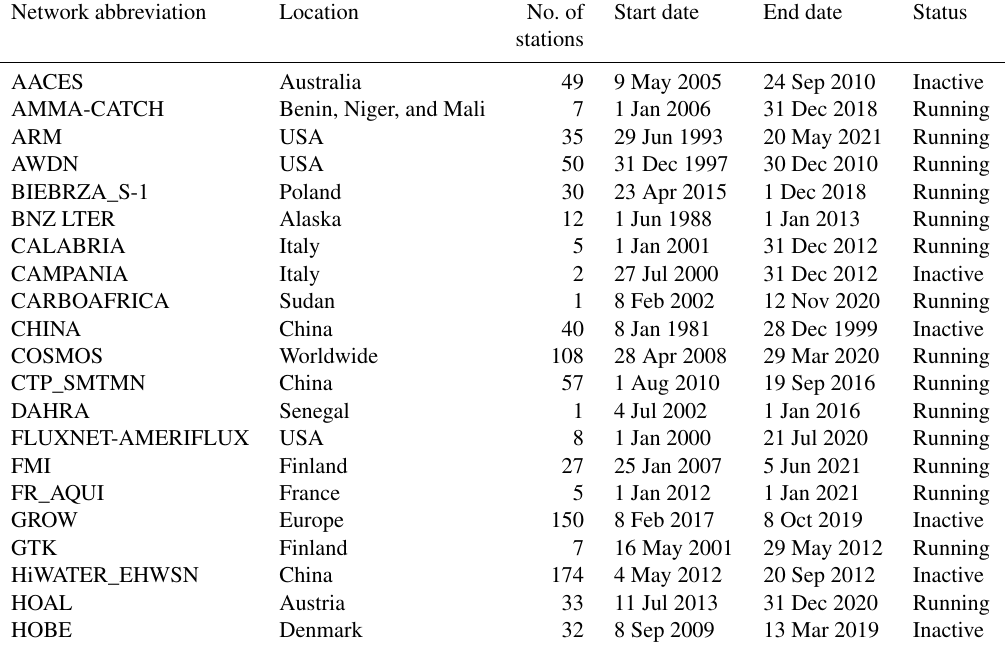
Table A1. Main properties of networks and data contained in the ISMN. Network